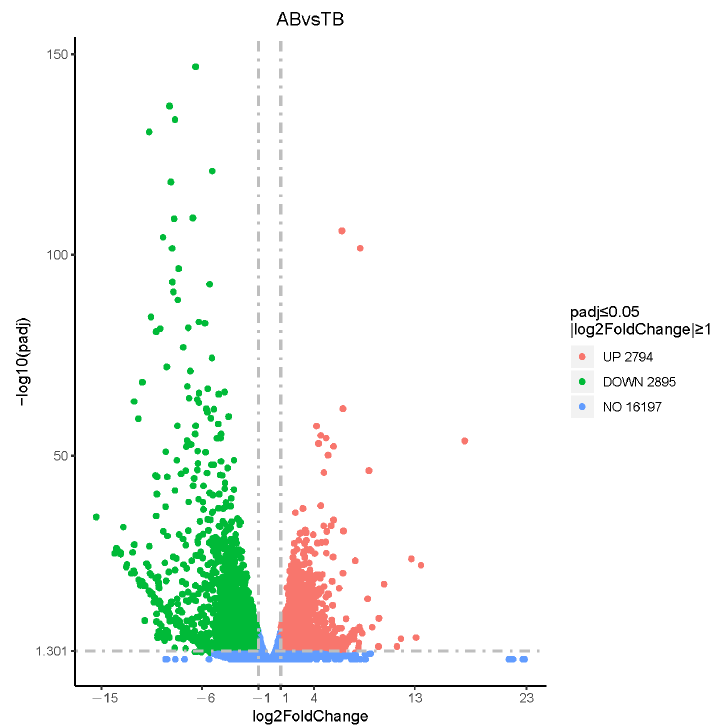
Figure 4. Volcano map of differentially expressed genes in comparison of different combinations. The abscissa is the log2FoldChange value, the ordinate is the − log10 p -value, and the blue dashed line represents the threshold line of differential gene screening criteria. Animals 2022 , 12 , x FOR PEER REVIEW